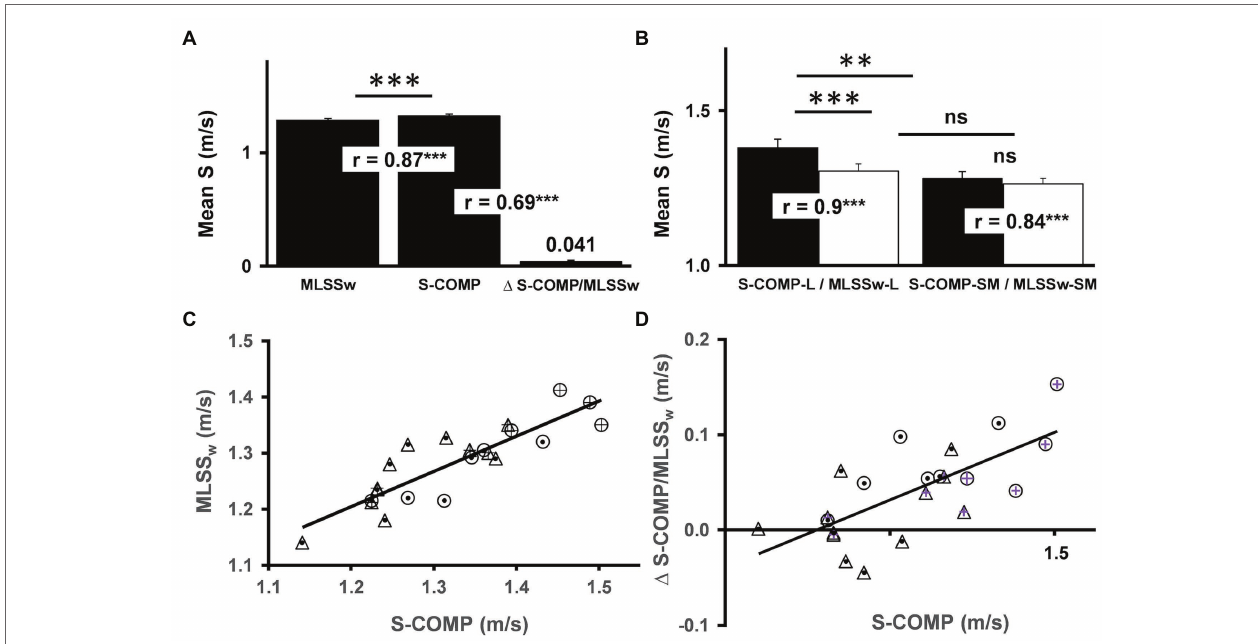
FIGURE 7 | Comparison of test and race results. (A) Comparison of swimming speed at MLSS W and swimming speed in competition (S-Comp) and their difference ( ∆ S-Comp/MLSS W ; MLSS W : 1.283 m/s vs. S-Comp: 1.326, ∗∗∗ p < 0.001, two-tailed paired t -test, r = 0.87, ∗∗∗ p < 0.001; S-Comp: 1.326 m/s vs. ∆ S-Comp/MLSS W : 0.041 m/s, r = 0.69, ∗∗∗ p < 0.001; n = 22). (B) Comparison of mean swimming speed at MLSS W and in competition (800 and 1,500 m, S-Comp) between long- distance swimmers (L, n = 10) and middle- and short-distance swimmers (SM, n = 12; S-Comp-L: 1.378 vs. MLSS W -L: 1.305, ∗∗∗ p < 0.001, two-tailed paired t -test, r = 0.9, ∗∗∗ p < 0.001; S-Comp-SM: 1.281 vs. MLSS W -SM: 1.264, ns., two-tailed paired t -test, r = 0.84, ∗∗∗ p < 0.001; S-Comp-L: 1.378 m/s vs. S-Comp-SM: 1.281 m/s, ∗∗ p < 0.01, two-tailed unpaired t -test; MLSS W -L: 1.305 m/s vs. MLSS W -SM: 1.264 m/s, ns., two-tailed unpaired t -test; ∆ S-Comp-L/MLSS W -L: 0.072 m/s vs. ∆ S-Comp-SM/MLSS W -SM: 0.015 m/s, ∗∗ p < 0.01, two-tailed unpaired t -test). (C) Relationship between swimming speed at the MLSS W and swimming speed in competition ( r = 0.87, p < 0.001; ○ = long distance group (L), ∆ = middle and short distance group (SM), + = men, ● = women). (D) Relationship between ∆ S-Comp/MLSS W and S-Comp ( r = 0.698, p < 0.001). Data are mean ± SE. S,